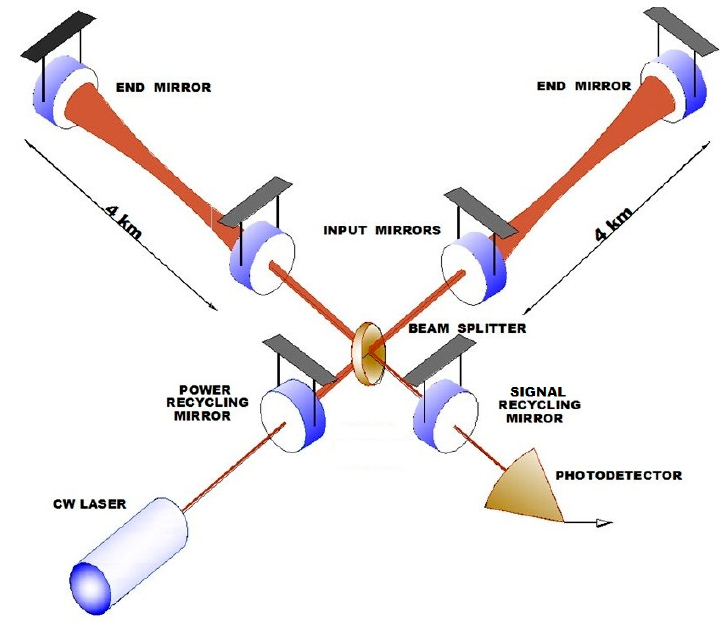
Figure 11. Advanced LIGO interferometer design concept. Figure made after T.F. Carruthers and D.H. Reitze, “LIGO”, Optics & Photonics News , March 2015.